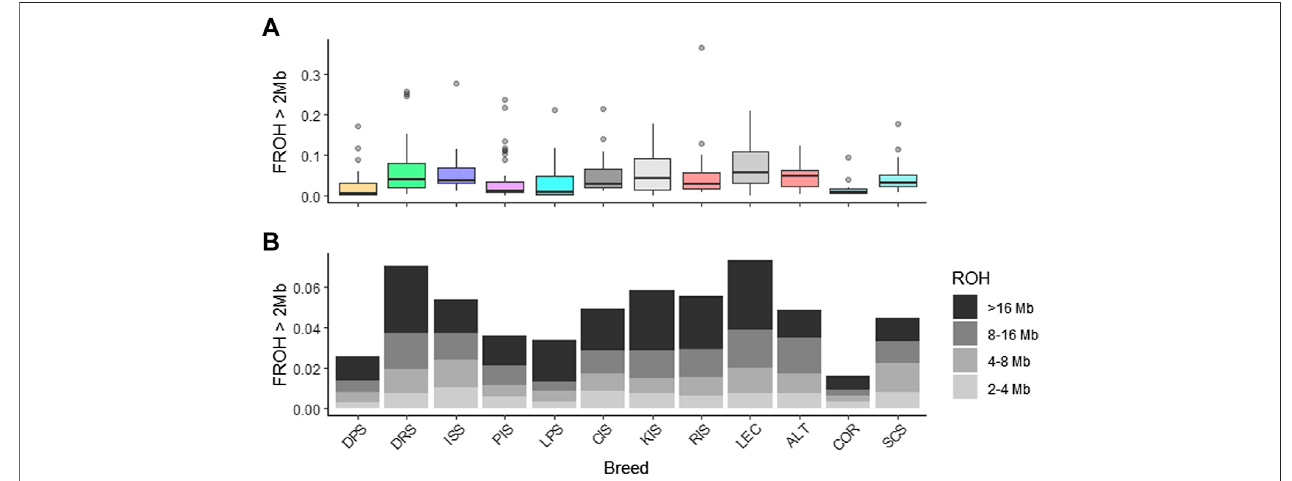
FIGURE 4 | Levels of genomic inbreeding. The genomic inbreeding coef fi cient (F ROH ) was estimated as the proportion of runs of homozygosity (ROH) in the total lengthofautosomes. (A) IndividualF ROH areaveragedperbreed. (B) ThepopulationmeanF ROH ispresentedforeachROHlengthcategory.Breedsarerepresentedwith a three letter coding: DRS, Dubrovnik Sheep; LPS, Lika pramenka; DPS, Dalmatian pramenka; PIS, Pag Island Sheep; RIS, Rab Island Sheep; CIS, Cres Island Sheep; KIS, Krk Island Sheep; ISS, Istrian Sheep; ALT, Altamunrana; LEC, Leccese; SCS, Churra; COR,